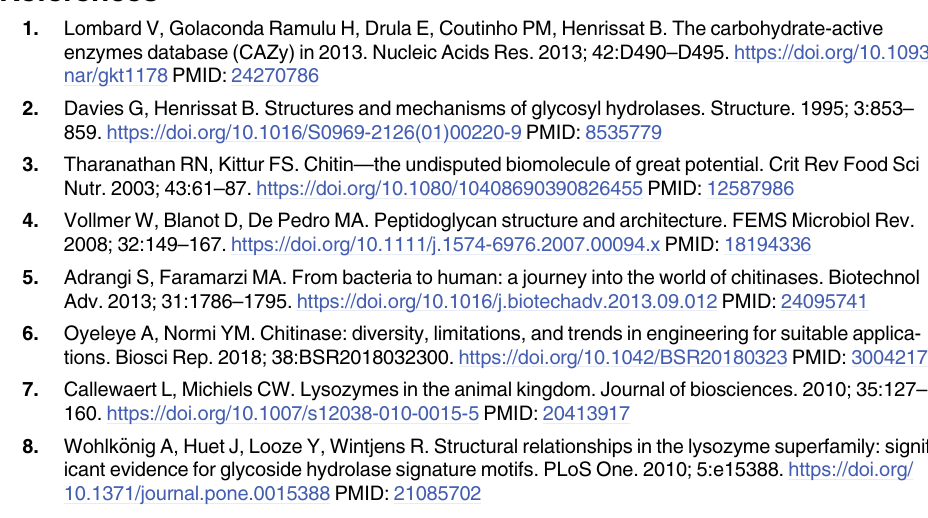
S9 Table. List of referenced CBM properties demonstrated by point mutation, by trunca- tion variants, or by comparing two similar enzymes from the same organism, with and without the